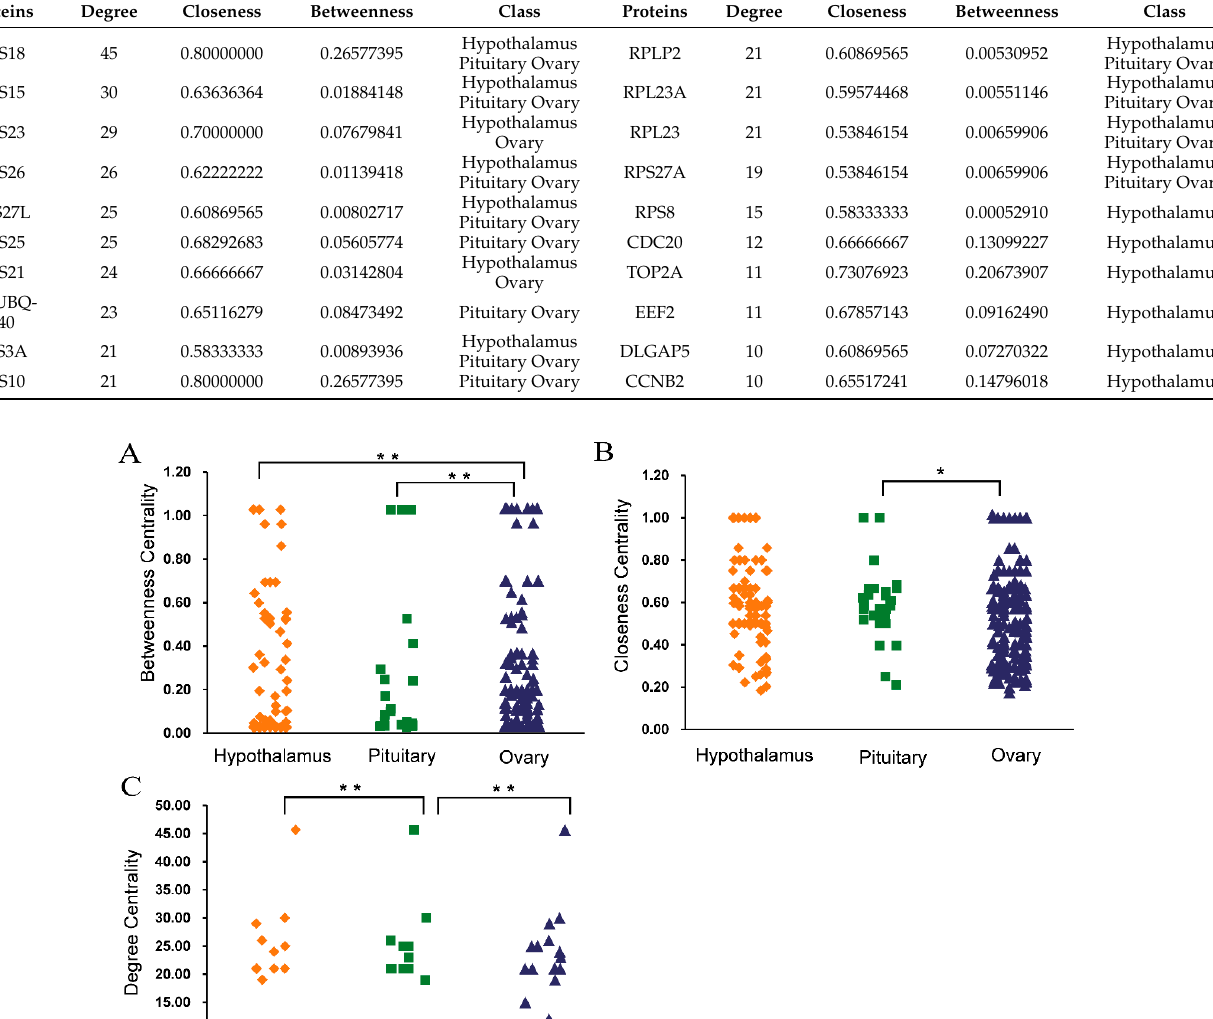
Table 3. Degree of node from protein-protein interaction network.